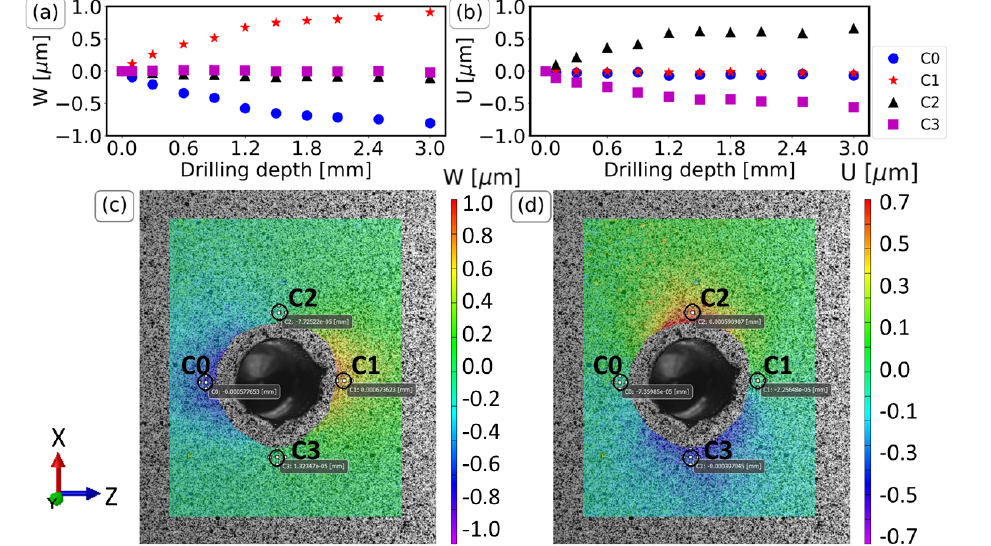
Figure 3. DIC results of the displacements W ( a , c ) and U ( b , d ) for the four points C0, C1, C2, C3. The plots ( a , b ) presents the average value for various drilling depths. The contours ( c , d ), as seen in VIC − 3D, illustrate the displacement field for a drilling depth of 1.2